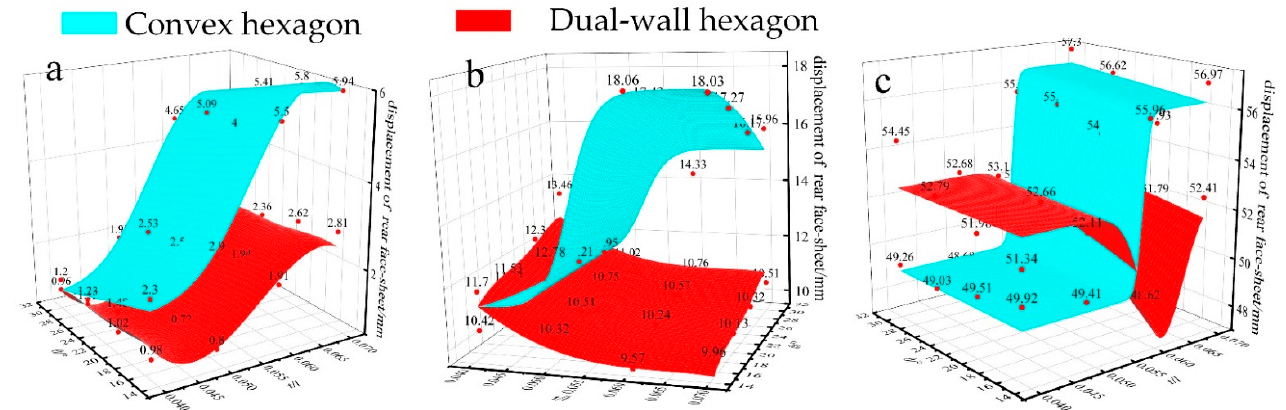
Figure 12. The rear face sheet displacement of the honeycomb sandwich structures at different impact speeds: ( a ) 25 m/s; ( b ) 50 m/s; ( c ) 100 m/s. speeds: ( a ) 25 m/s; ( b ) 50 m/s; ( c ) 100